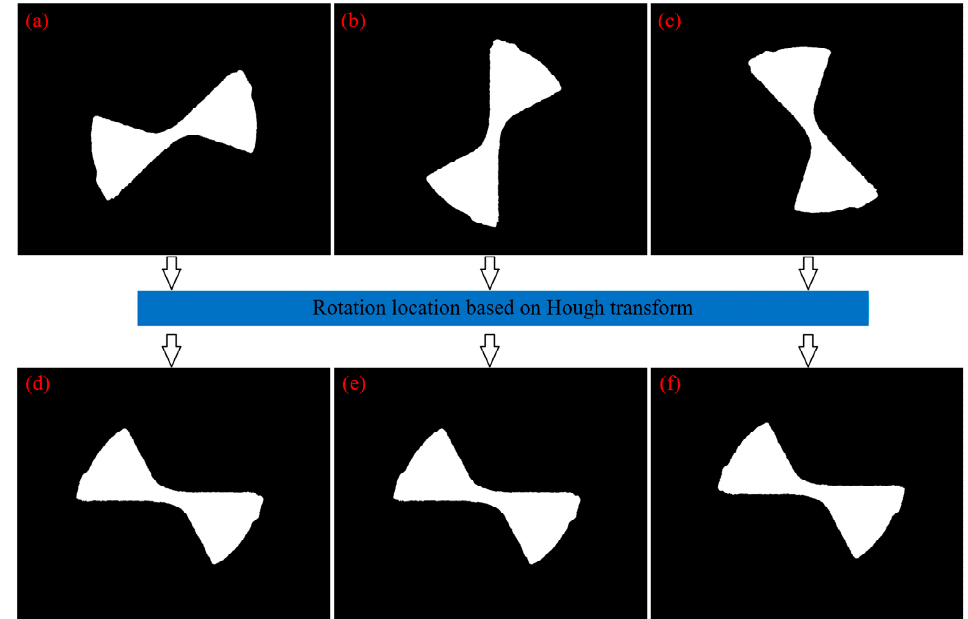
Figure 14. Simulation of tool rotation and positioning based on Hough transform: ( a ) 0~90°; ( b ) 90°; ( c ) 90~180°; ( d – f ) Images after rotation and positioning.